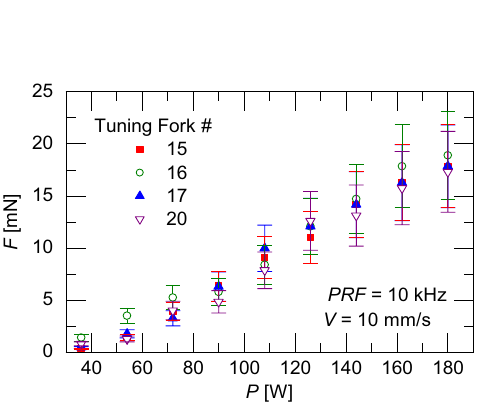
Figure 5. Recoil force versus applied laser power for single line scanning strategies using Tuning Forks #15, #16, #17, and